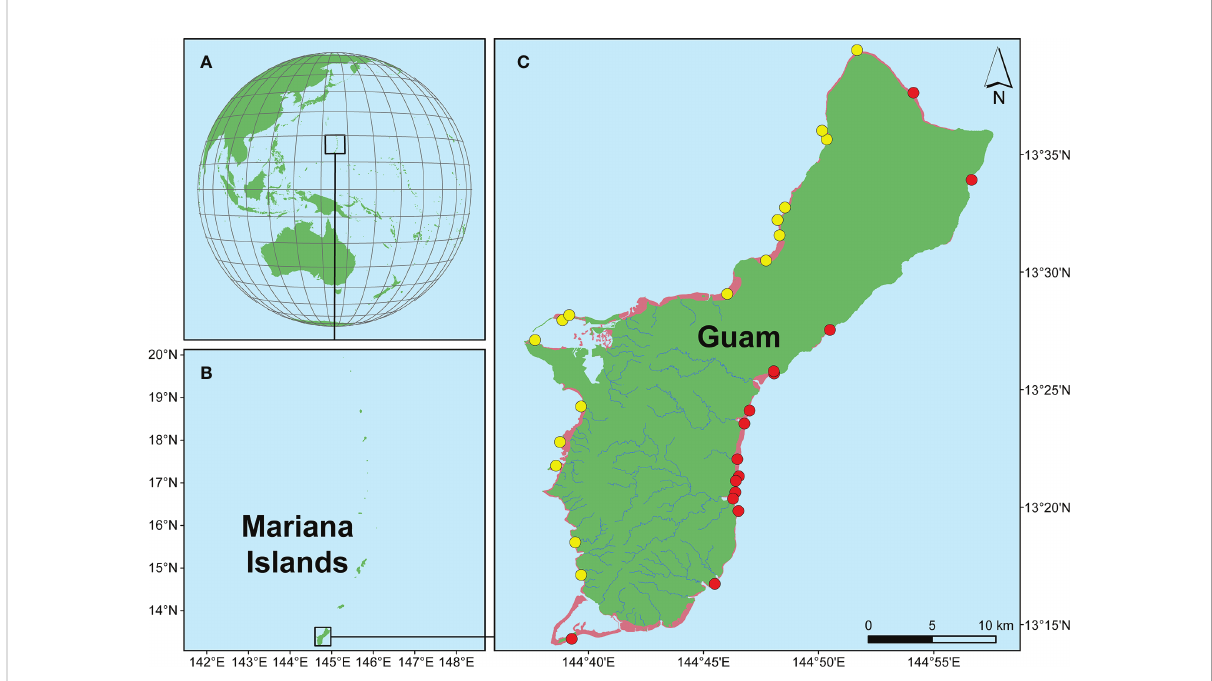
FIGURE 1 Maps indicating the study area and sample collection sites. (A) Paci fi c-centered map showing the location of the Mariana Islands. (B) Map of the Mariana Islands with Guam as the largest and southernmost island. (C) Map of Guam identifying the 31 sites from which CCRA were collected, separated into eastern sites (red dots) and western sites (yellow dots). Scale bar = 10